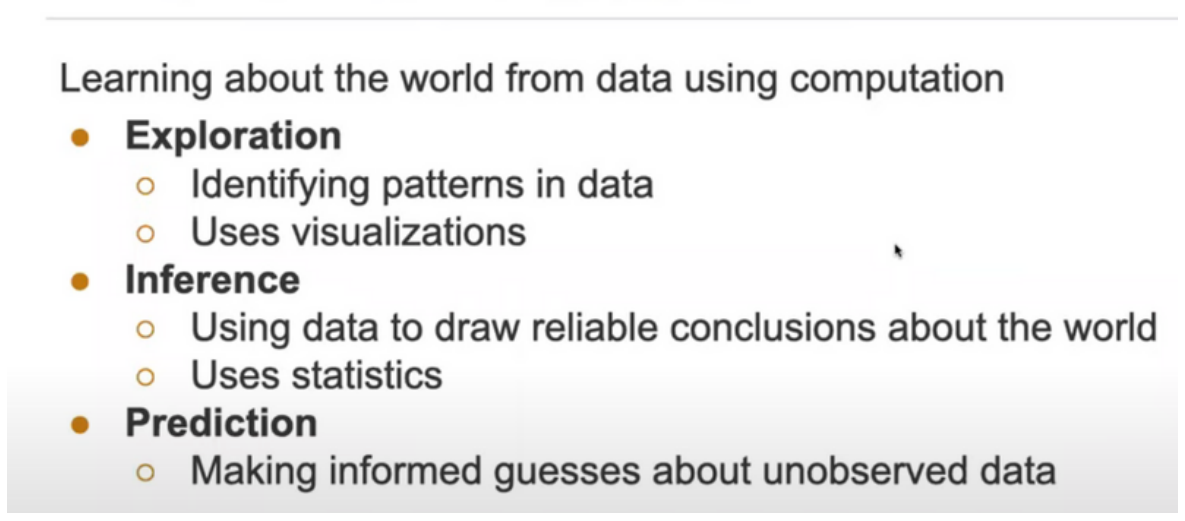
Figure 1. Visual from Berkeley Data 8 defining data science (Sahai,